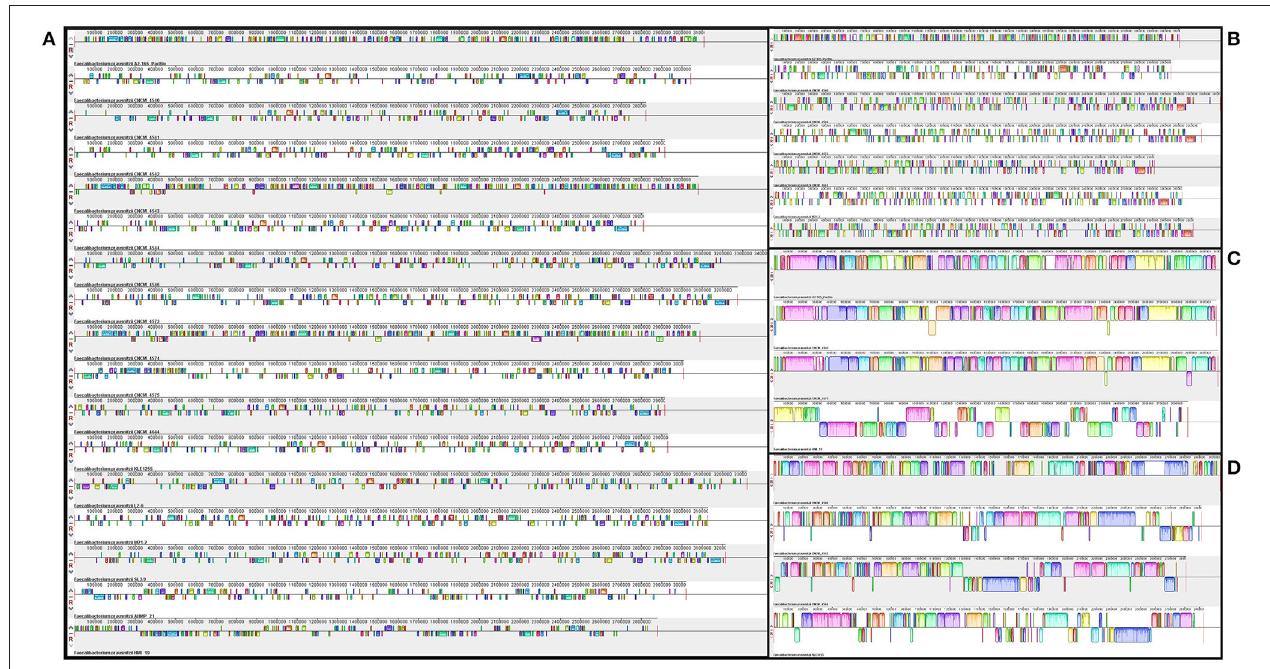
FIGURE 4 | Genomic synteny and gene conservation among the genomes of F. prausnitzii . The left side of the figure (A) shows the LCBs of all genomes studied here. The right side depicts the LCBs of the genomes within each of the three clusters previously obtained from ANI analysis: top right (B) —cluster A, middle right (C) —cluster B, and bottom right (D) —cluster